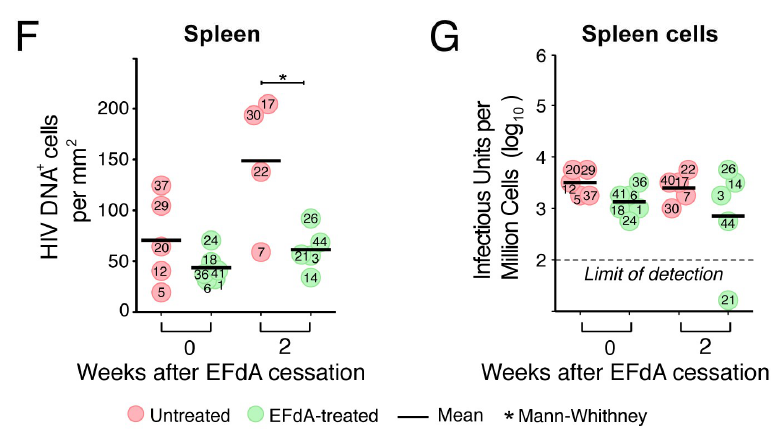
Figure 5. Fully suppressive EFdA therapy does not eliminate HIV DNA + cells in the spleen. HIV DNA was detected in NSG-BLT mouse spleens by a DNAscope multiplex fluorescent ( A , C , D ) and chromogenic ( B , E , F ) assays using an HIV-1 clade B sense probe. DNAscope labeling of HIV DNA was combined with fluorescent co-immunolabeling for human CD3 (hCD3) and CD163 (hCD163) ( A , C , D ) or chromogenic immunolabeling for CD163 (hCD163) ( B , E ). Nuclei were counterstained with DAPI ( A , C , D ) or hematoxylin ( B , E ). HIV DNA in panels ( B ) and ( E ) was visualized by alkaline phosphatase-Fast Red fluorescence detection. The region of interest is outlined by dashed light blue rectangles ( A – E ) and magnified in the insets. The results are representative of those observed in 5 or 6 spleen samples in untreated ( A , B ) and EFdA-suppressed groups ( C , D , E ). ( F ) Fifty images of the representative white pulp regions containing human CD3 + and CD163 + cells were acquired at a magnification of 630 × for each spleen. HIV DNA + cells were enumerated by ImageJ software. The results of 3 DNAscope assays with 3 tissue sections per spleen are represented as the mean value. ( G ) Infectious units per million (IUPM) cells assay with dispersed spleen cells. The IUPM assay was performed with 32,000, 10,000, and 3200 spleen cells co-cultivated with phytohemagglutinin-stimulated PBMC for 7 days, and IUPM were determined by detection of p24 in supernatants. The upper limit of detection is, therefore, 3.75 log 10 infectious units per million spleen cells and is likely greater for 2 of the untreated mice. The Mann − Whitney U-test performed a statistical comparison between the groups and was considered significant at * P < 0.05 ( F ). Organ numbers 37 ( A , B ), 24 ( C , D ), 6 ( E ) indicate mouse numbers shown in panels ( F ) and ( G